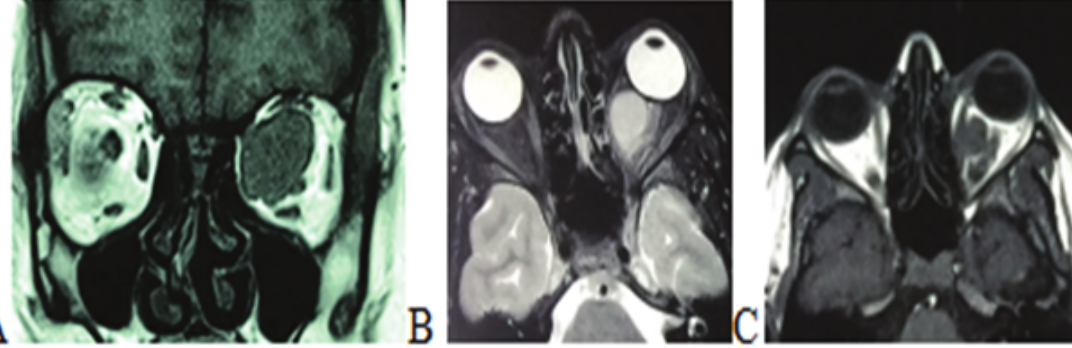
Figure 1. Orbital Magnetic Resonance Imaging (MRI). (A) Coronal image illustrating a superonasal intraconal mass on T1-weighted images which is separated from optic nerve. (B & C) Axial image illustrates a hypointense oval-shaped intraconal mass on T1- weighted images and hyperintense on T2-weighted images.